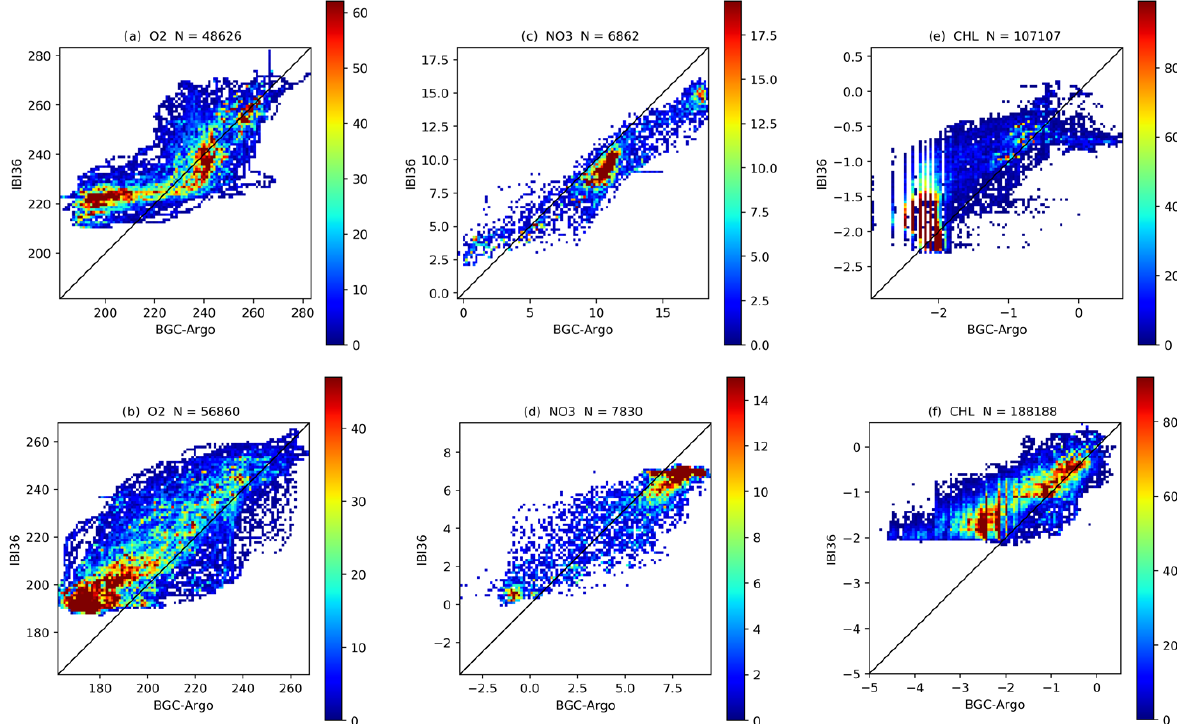
Figure 15. Density plots for oxygen (a, b) , nitrate (c, d) and log(Chl a ) (e, f) from BGC-Argo data and IBI36 for the Atlantic (top) and Mediterranean (bottom). Oxygen and nitrate are expressed in µmolL − 1 . Argo data are on the x axis and IBI36 on the y axis of the density plots. Each axis is divided in 100 bins and the colour bar represents the density of the match-ups (number of overlapping points). Note the different scales for the variables. N indicates the total number of match-ups. IBI36 and Argo data are collocated in space and